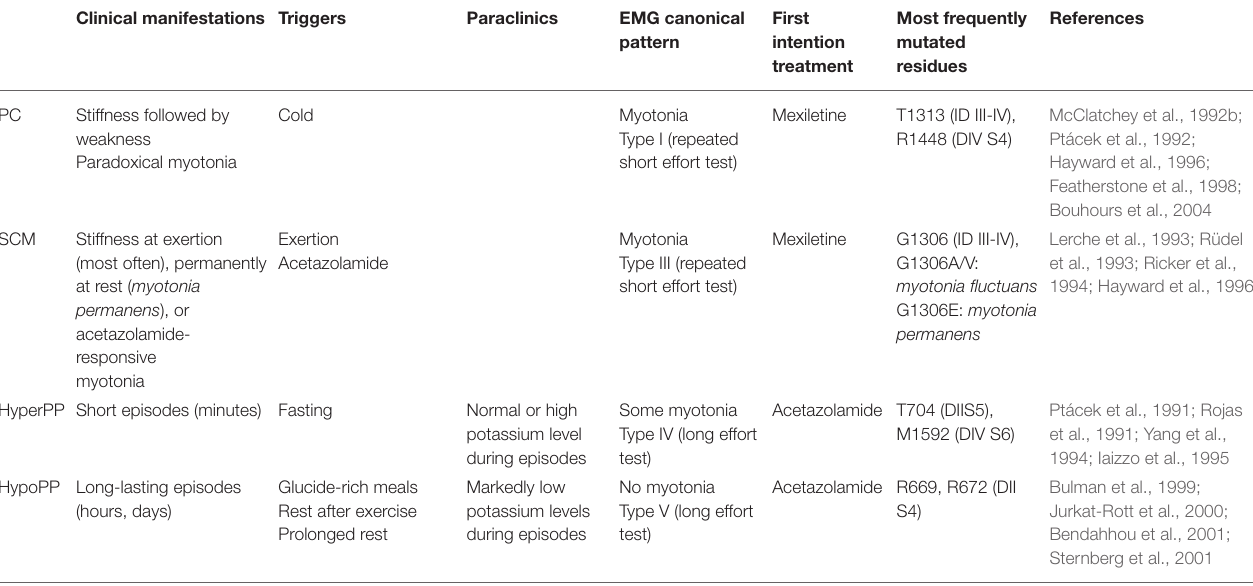
TABLE 1 | Main classes of Nav1.4 skeletal muscle channelopathies (Trip et al., 2009; Raja Rayan and Hanna,